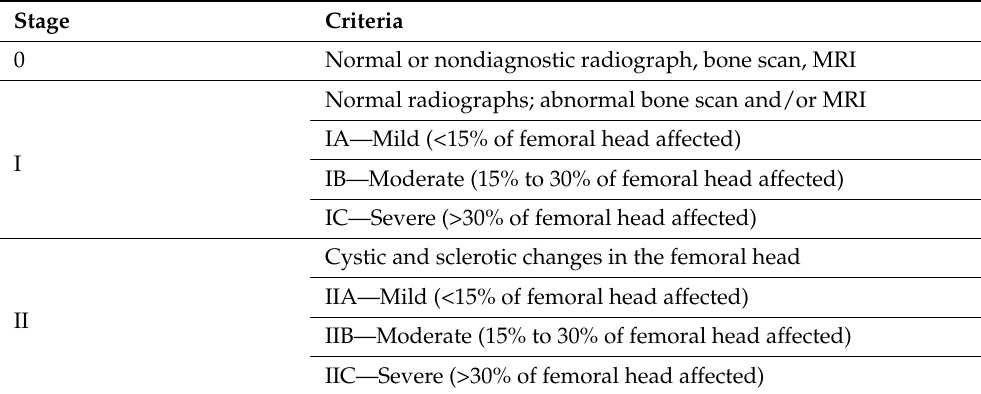
Table 3. Steinberg’s classification of avascular necrosis of the femoral head